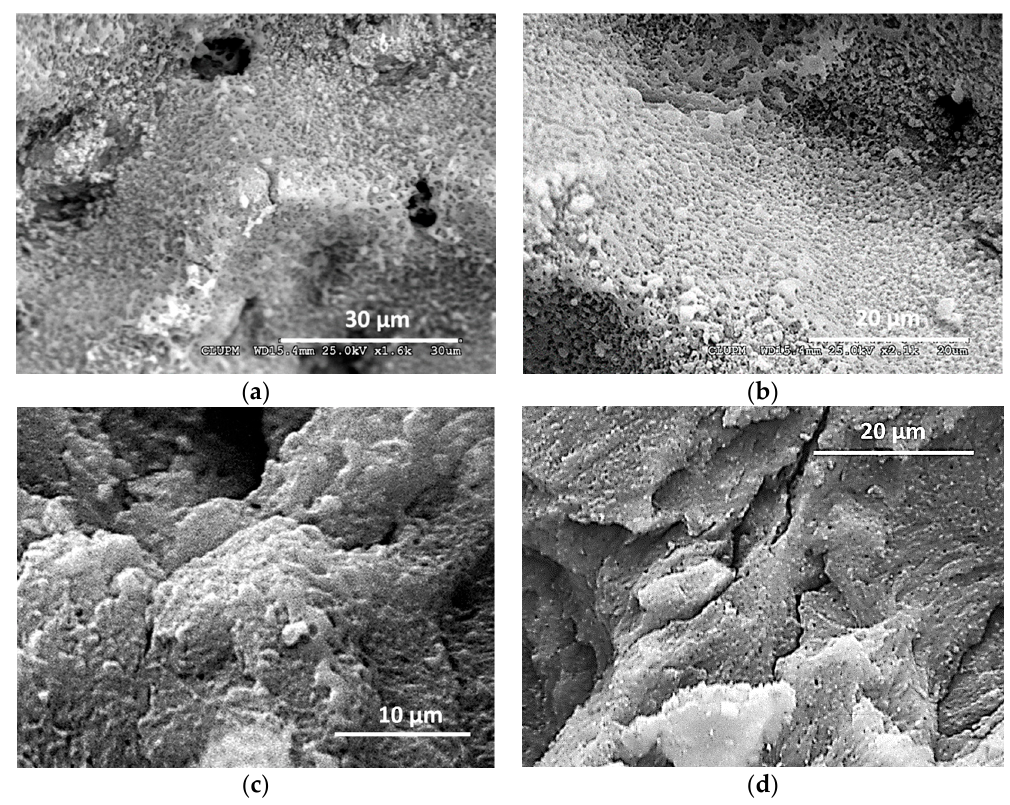
Figure 4. SEM images of bone samples ablated using the UV ns laser pulse. Melted material (rounded shapes) is an indication of thermal damage. The pulse fluence, process speed, repetition frequency, pitch, and number of cycles used for each sample are, respectively: ( a ) 38.2 J/cm 2 , 6000 mm/s, 100 kHz, 50 µm, 100; ( b ) 49.2 J/cm 2 , 4000 mm/s, 60 kHz, 50 µm, 80; ( c ) 49.2 J/cm 2 , 4000 mm/s, 60 kHz, 50 µm, 20;